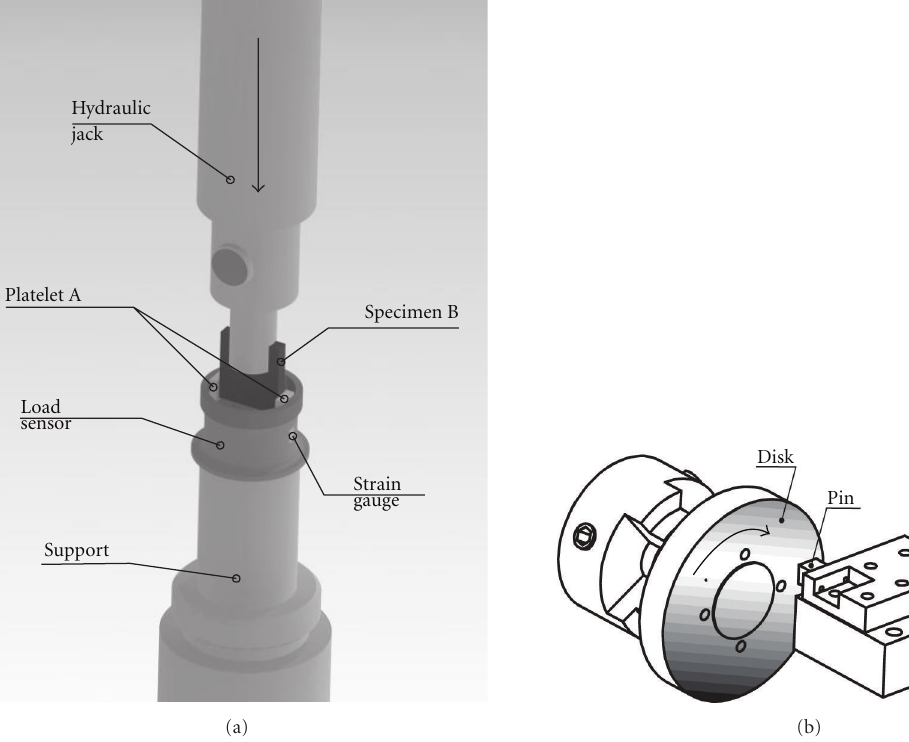
Figure 3: (a) Load sensor adapted for a servohydraulic machine. (b) Pin-on-disk tribometer mounted on a CNC lathe.